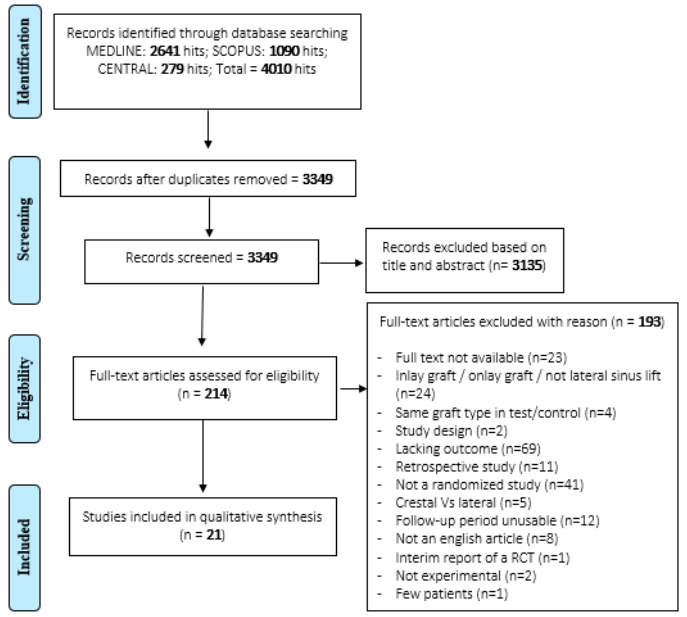
Figure 1. Flowchart of the included studies.